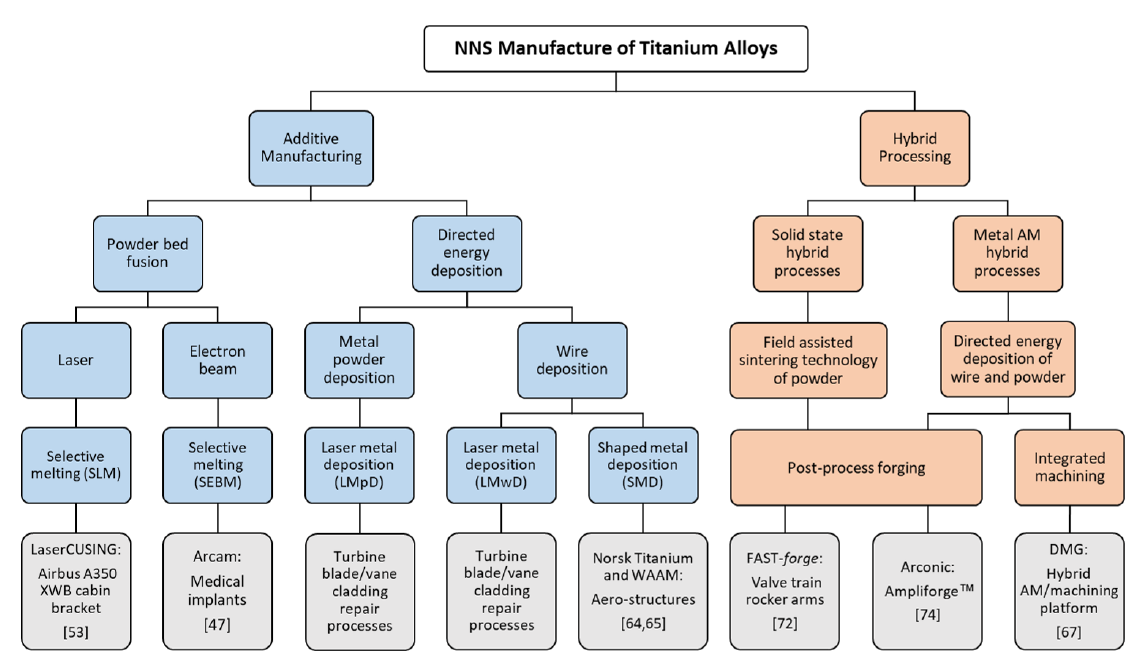
Figure 2. A schematic summary of emerging NNS manufacturing methods suitable for the manufacture of titanium alloys components from powder and wire